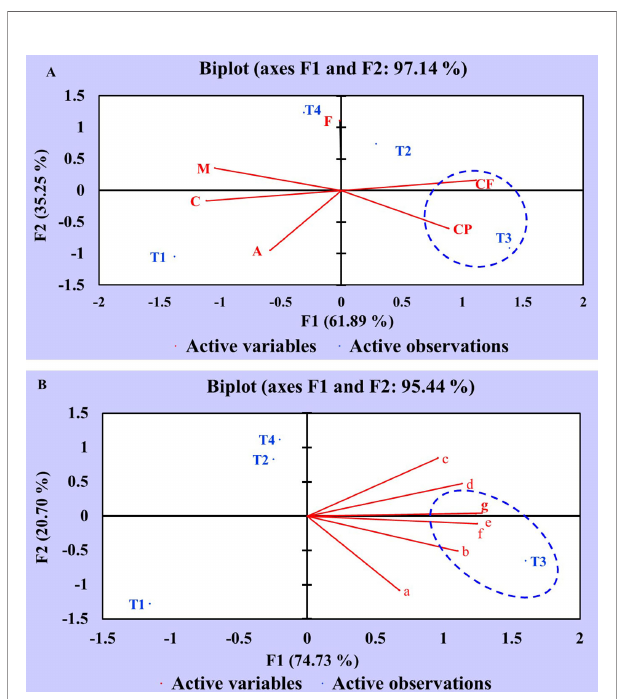
FIGURE 5 | Principal Component Analysis showing the correlation between the effect of different treatments and variables of C. annuum L. (A) Principal component analysis of different treatments and proximate chemical constituent variables. (B) Principal component analysis of different treatments and nutrient constituent variables. Where, treatments: T1: Untreated control; T2: seeds + CDK15; T3: seeds + CDK25; T4: seeds + Consortium (CDK15 + CDK25); M: Moisture, CP: Protein, CF: Crude Fiber, A: Ash, F: Fat, C: Carbohydrate, a: Calcium; b: Magnesium; c: Phosphorous; d: Potassium; e: Copper; f: Zinc; g: